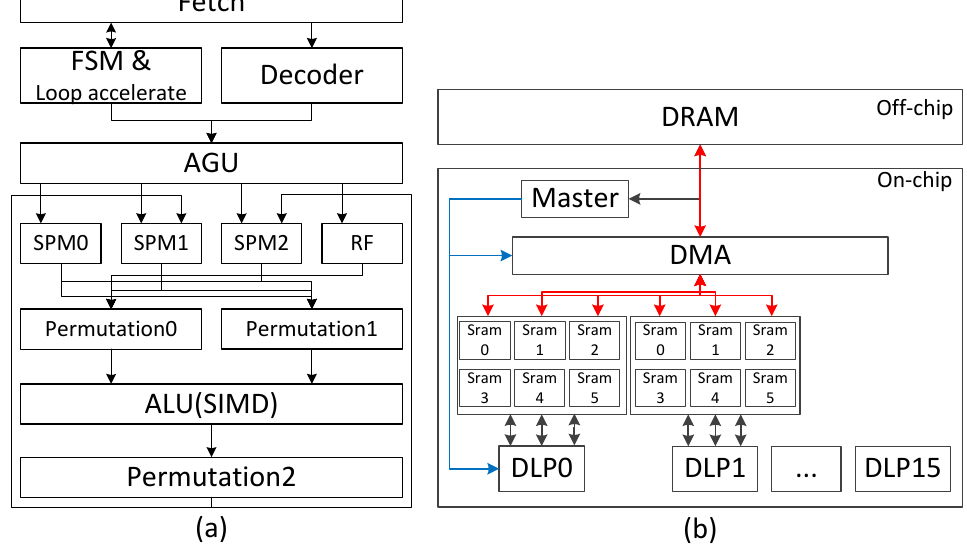
Figure 6. The hardware design. ( a ) PE micro-architecture. ( b ) Soc-level extension